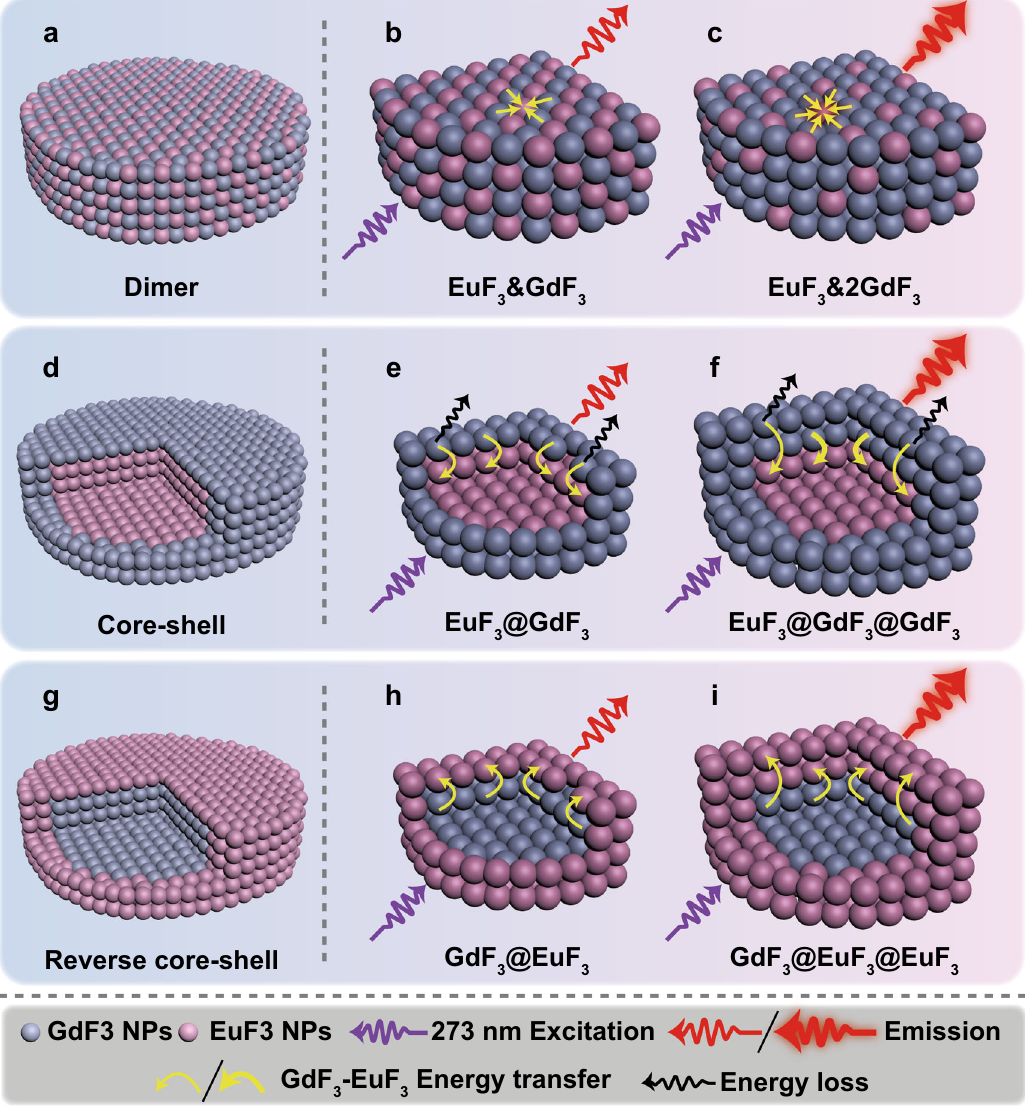
Fig. 4 Schematic illustration of the structures and energy transfer pathways of different NCs. The structures of a dimeric, b EuF 3 &GdF 3 , and c EuF 3 &2GdF 3 NCs. d Core-shelled, e EuF 3 @GdF 3 , and f EuF 3 @GdF 3 @GdF 3 NCs. g Reversely core-shelled, h GdF 3 @EuF 3 , and i GdF 3 @EuF 3 @EuF 3 NCs, as well as their respective energy transfer pathways. b , c , e , f and h , i illustrate the energy transfer details in differently structured NCs using 273 nm light to excite Gd 3 + , which transfers energy to Eu 3 + (Supplementary Fig. 11). Note: for simplicity, energy migrations between Gd 3 + – Gd 3 + and Eu 3 + – Eu 3 + were not